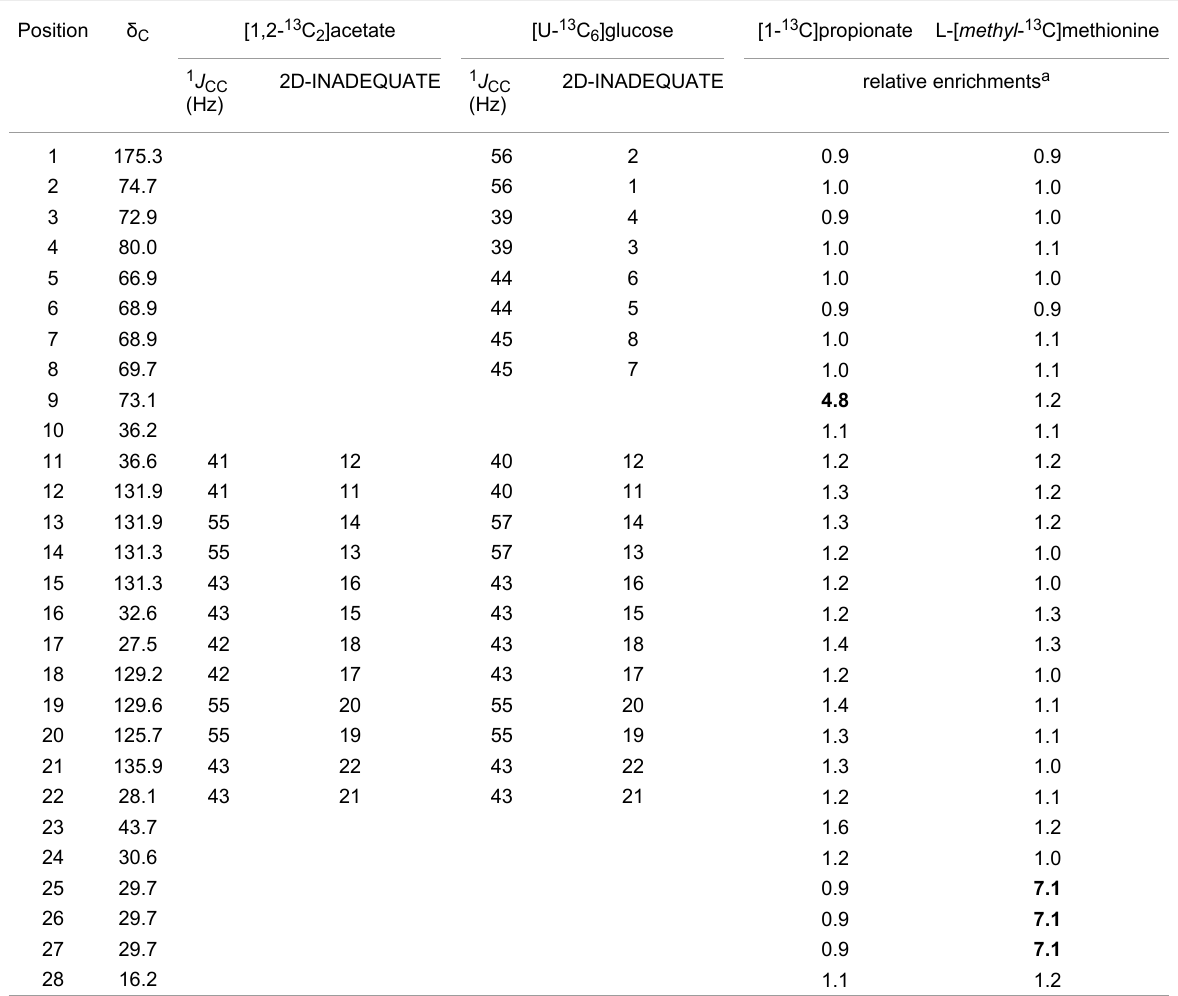
Table 1: Incorporation of 13 C-labeled precursors into 1 .